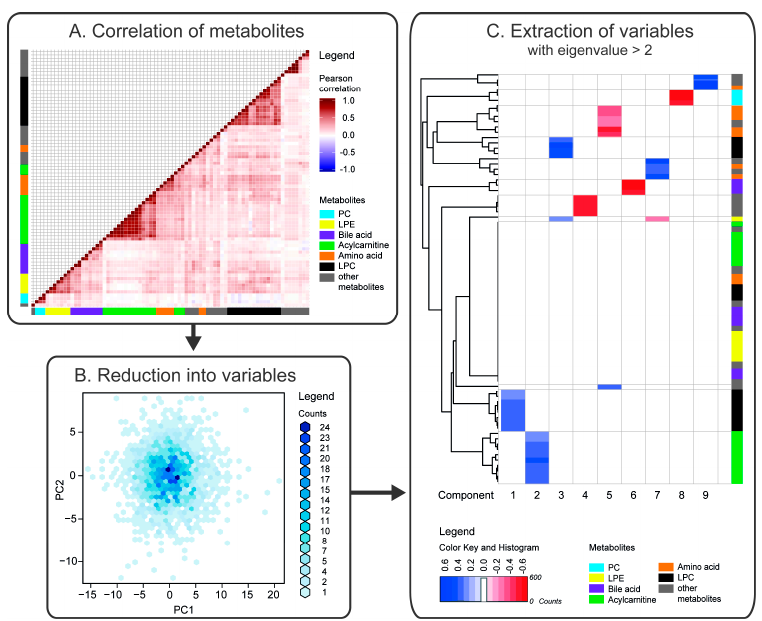
Figure 1. Schematic overview of correlation and principal component analyses (PCA) revealing independent clusters of metabolites. ( A ) Metabolite profiles are highly correlated. Pearson correlation coefficients for metabolite pairs (rows and columns) are shown. Several distinct clusters that correspond to biochemical pathways were observed, including phosphatidylcholine (PC, light blue), lyso-PC (LPC, black), lysophosphatidylethanolamine (LPE, yellow), acylcarnitine (green), bile acid (purple), and amino acid (orange) clusters. ( B ) PCA was employed to reduce the number of correlated metabolites by transforming them into uncorrelated metabolite factors. Density coloured scatter plot indicating the scores for the first two principal components (PC1 and PC2). The score plot hence indicates similarities and differences between the metabolite profiles of the subjects. The relation to the original variables, i.e., the metabolites, is described by the loadings (not shown). ( C ) The loading matrix contains non-zero values for all metabolites in all components. Hence, varimax rotation was conducted on the 18 principal components with eigenvalues > 1 to improve the interpretation of the factors. Heat map displays varimax-rotated loadings for the first 9 factors with eigenvalues ≥ 2, in which |loadings| ≤ 0.2, indicating only small contribution to the component, were coloured in white. Hence, the first component is largely composed of LPCs (black) and the second by acylcarnitines (green). Detailed graphs of Figure 1A,C are available in Figure S3.